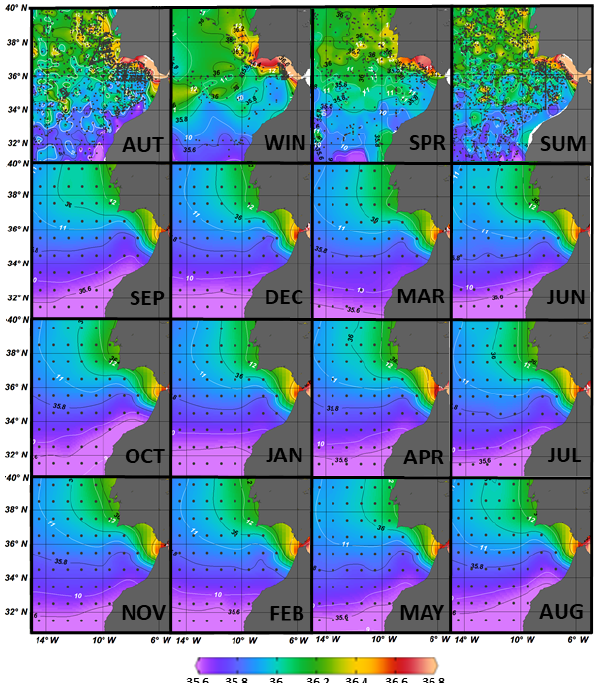
Figure 3. Observed salinity on the isopycnic surface σ = 27 . 5 for the different seasons (top row). The rows below show the same distributions for each climatological month as shown by WOA data. The white lines represent the temperature values at density σ = 27 .